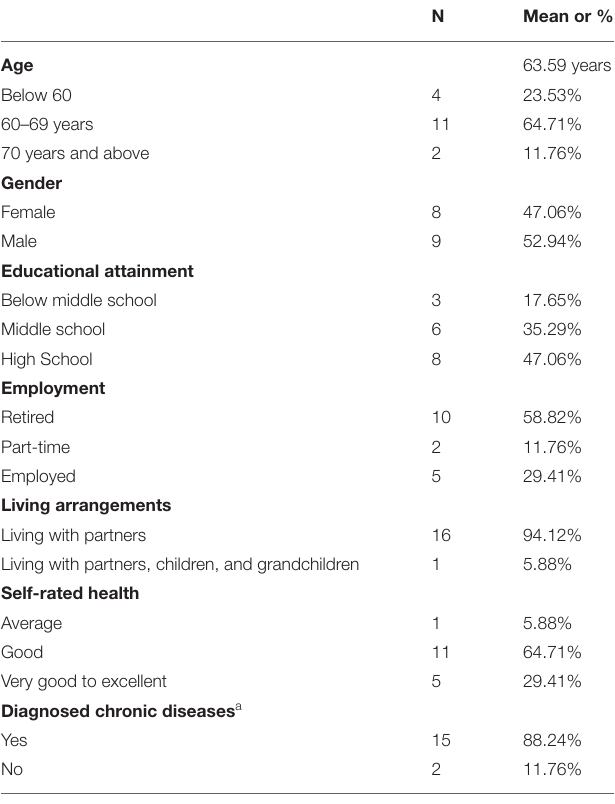
TABLE 1 | Demographic characteristics, self-rated health, and diagnosed chronic diseases of interviewees aged 55 and above, N =